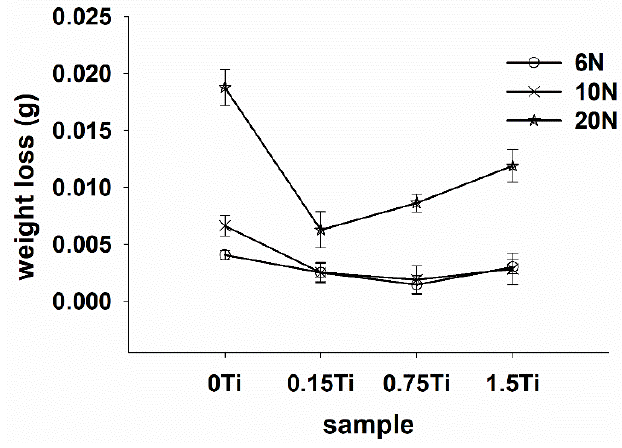
Figure 7. The difference of the average wear loss as a function of the normal loads for Mg-5Sn-xTi samples.